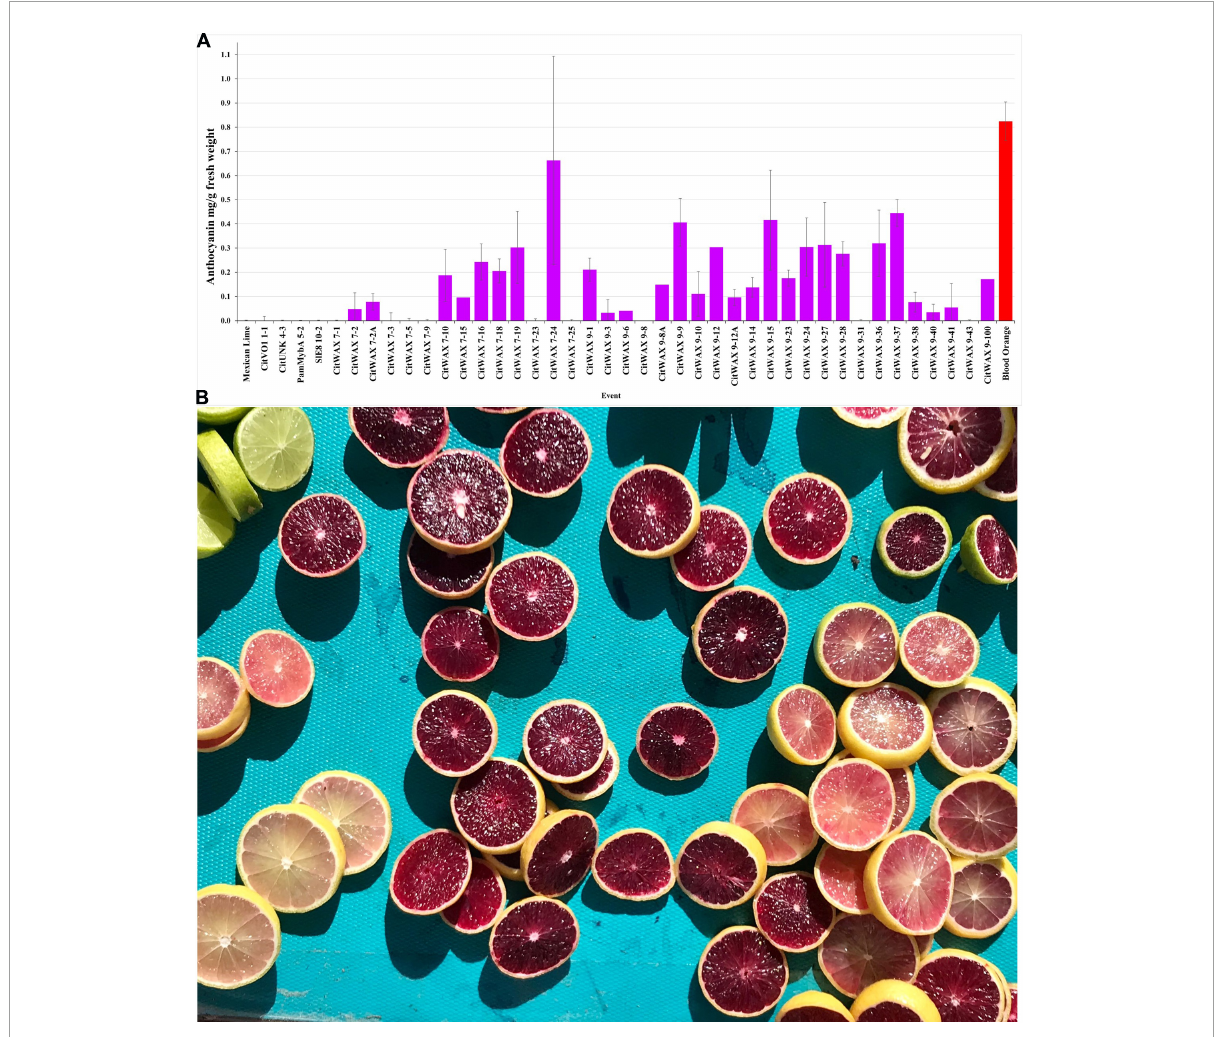
FIGURE3 (A) Anthocyanin accumulation in Mexican lime fruit. Juice was collected from fruit and the anthocyanin content was determined spectrophotometrically. Wildtype Mexican lime (far left) and Moro blood orange (far right, red bar) are shown as comparators for the transgenic events (middle). A single representative event is shown for the CitVO1, CitUNK, PamMybA, SlE8 transgenic trees, while all of the characterized CitWax events are shown (fuchsia bars). (B) Mexican lime fruit derived from the CitWax-Ruby construct exhibited fruit of multiple purple hues. For comparison, wildtype Mexican lime fruit is shown in the upper left